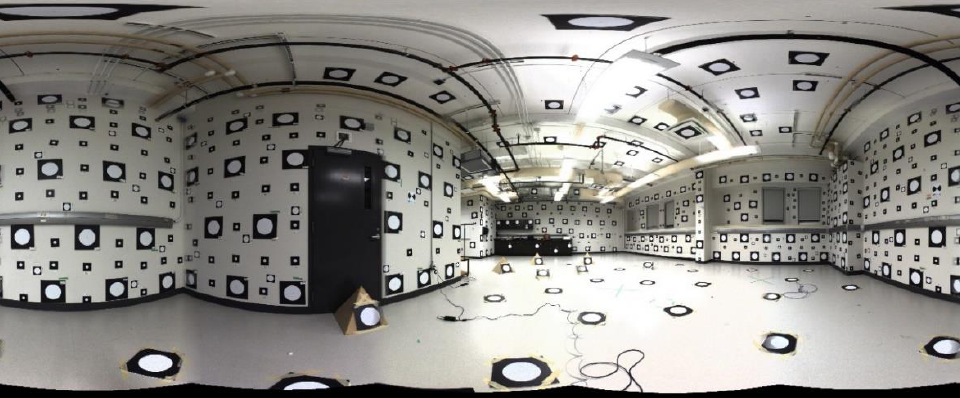
Figure 4. Panoramic view of calibration